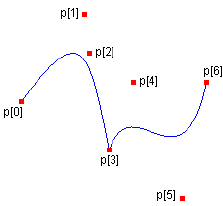
Figure 28. Two splines connected in the middle point The reconstruction becomes smoother, even if surface breaklines are accepted. Notice that discontinuities of